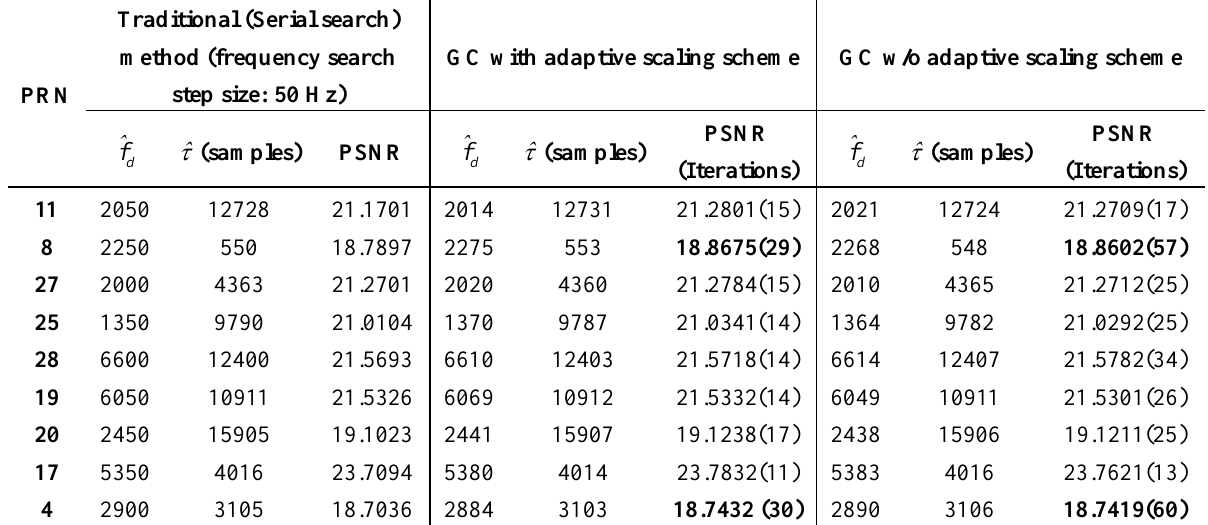
Table 2. Acquisition results of three methods.